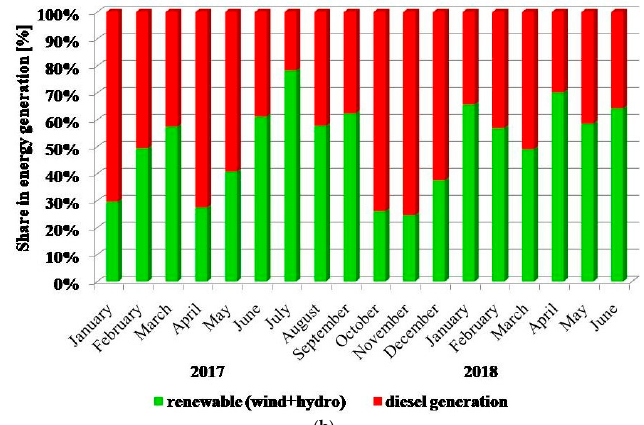
Figure 11. The share of individual sources in energy generation ( a ) from 27 June 2015, to the end of December 2016, ( b ) from 1 January 2017, to the end of June 2018, based on the own elaboration of the Red Eléctrica de España data.